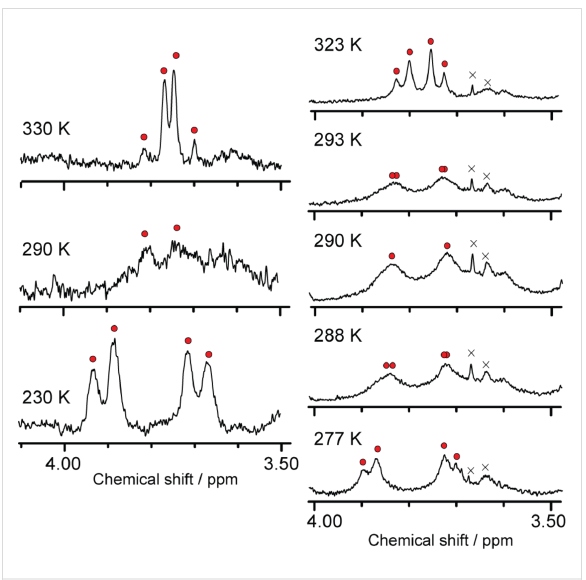
Figure 9: Temperature-dependent 1 H NMR spectra of 4a in C 2 D 2 Cl 4 (left) at 300 MHz, and (right) at 500 MHz for precise analysis.